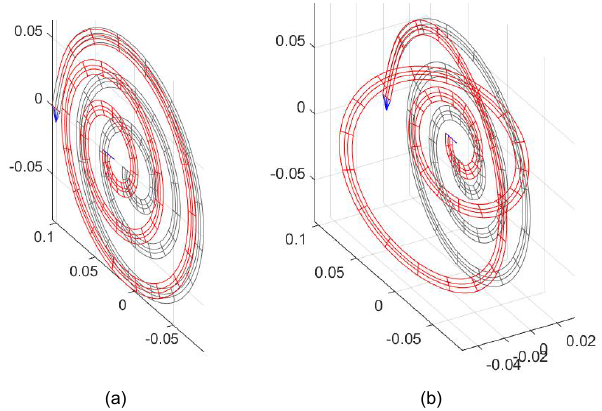
Figure 12. (a) An in-plane displacement is applied to a flat spiral. (b) An additional small out-of plane displacement brings the spiral in a post-buckling